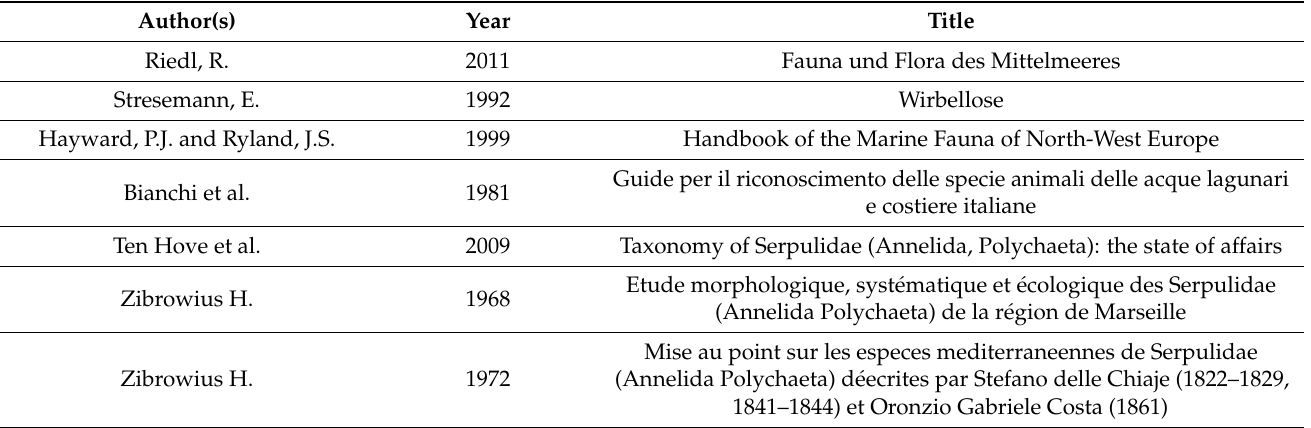
Table A1. Literature used for identification of species.